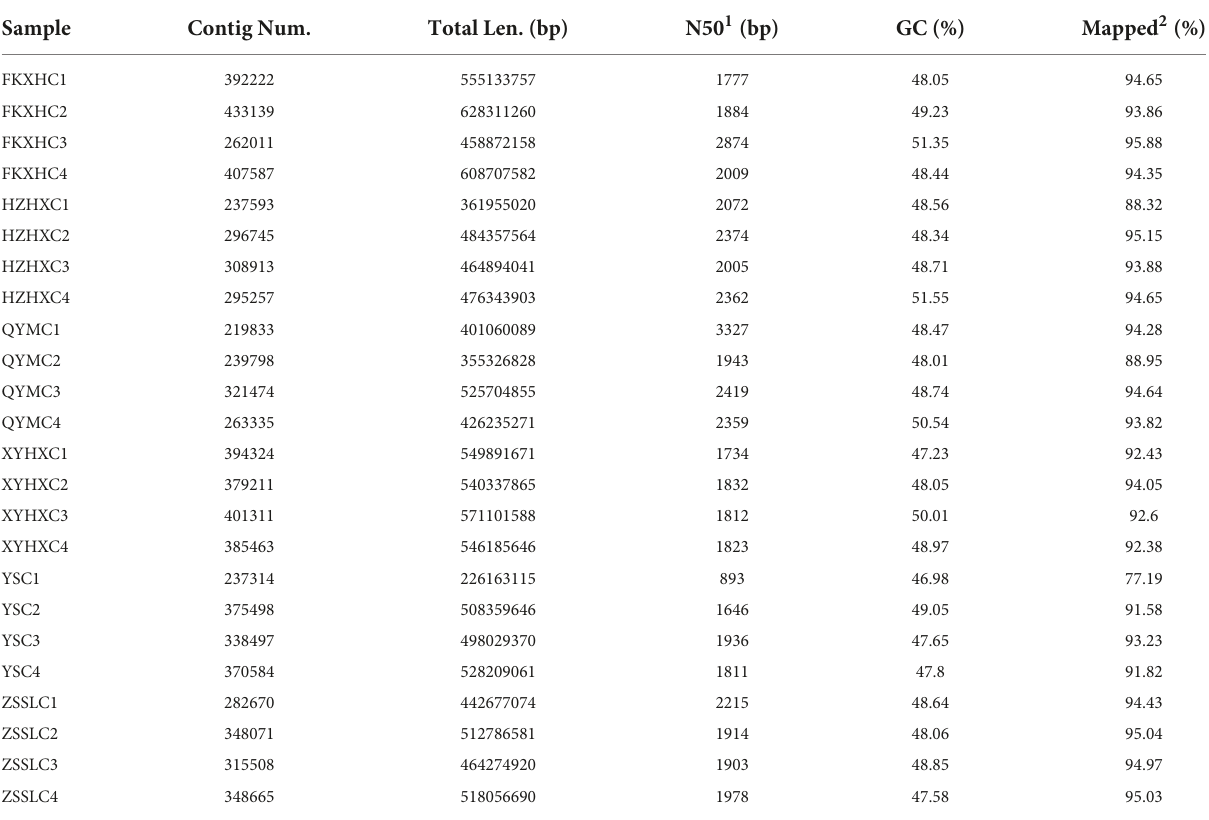
TABLE 1 Sequenced reads analysis and assembly